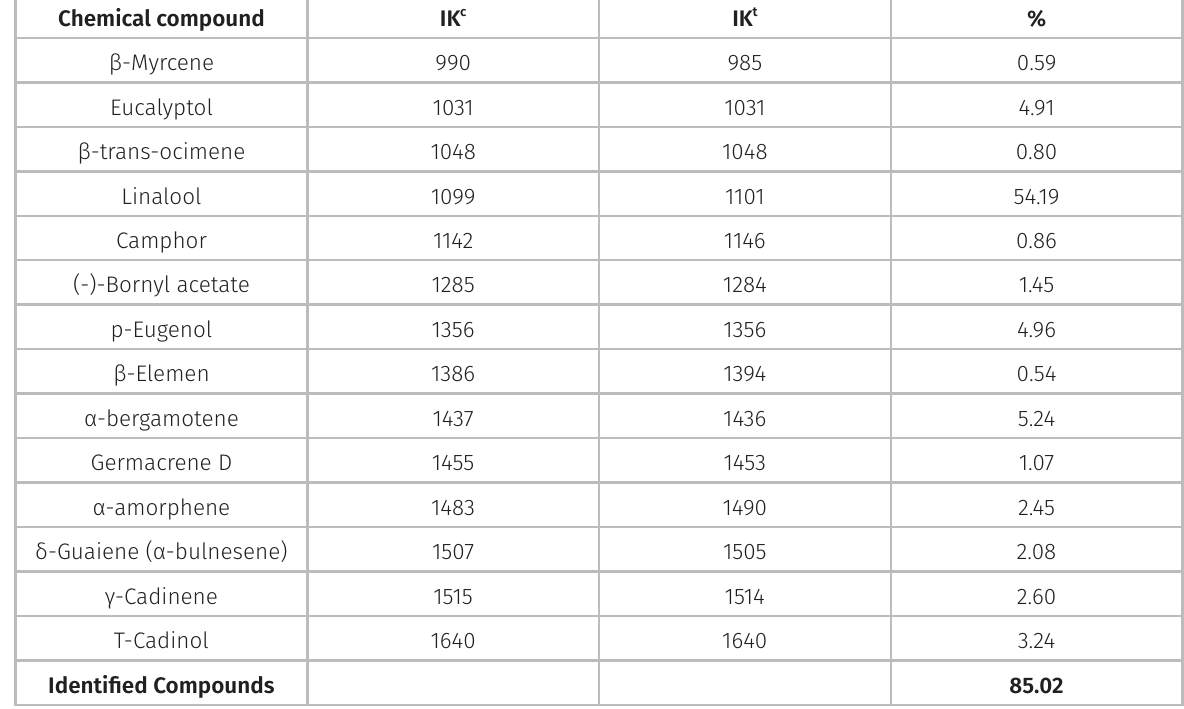
Table I. Chemical composition of essential oil of Ocimum basilicum . IKc: retention índex calculated. IKt: retention index reference (NIST 2008). %: relative